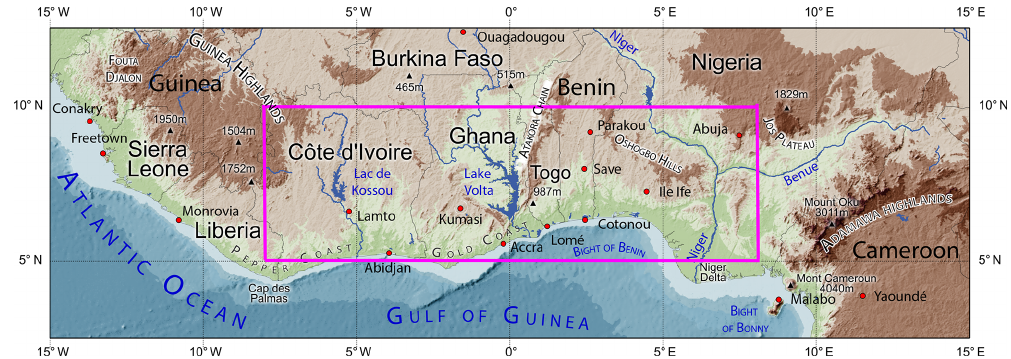
Figure 1. Map of southern West Africa indicating the geographical locations referenced in the text. Low-level clouds were modified within the pink